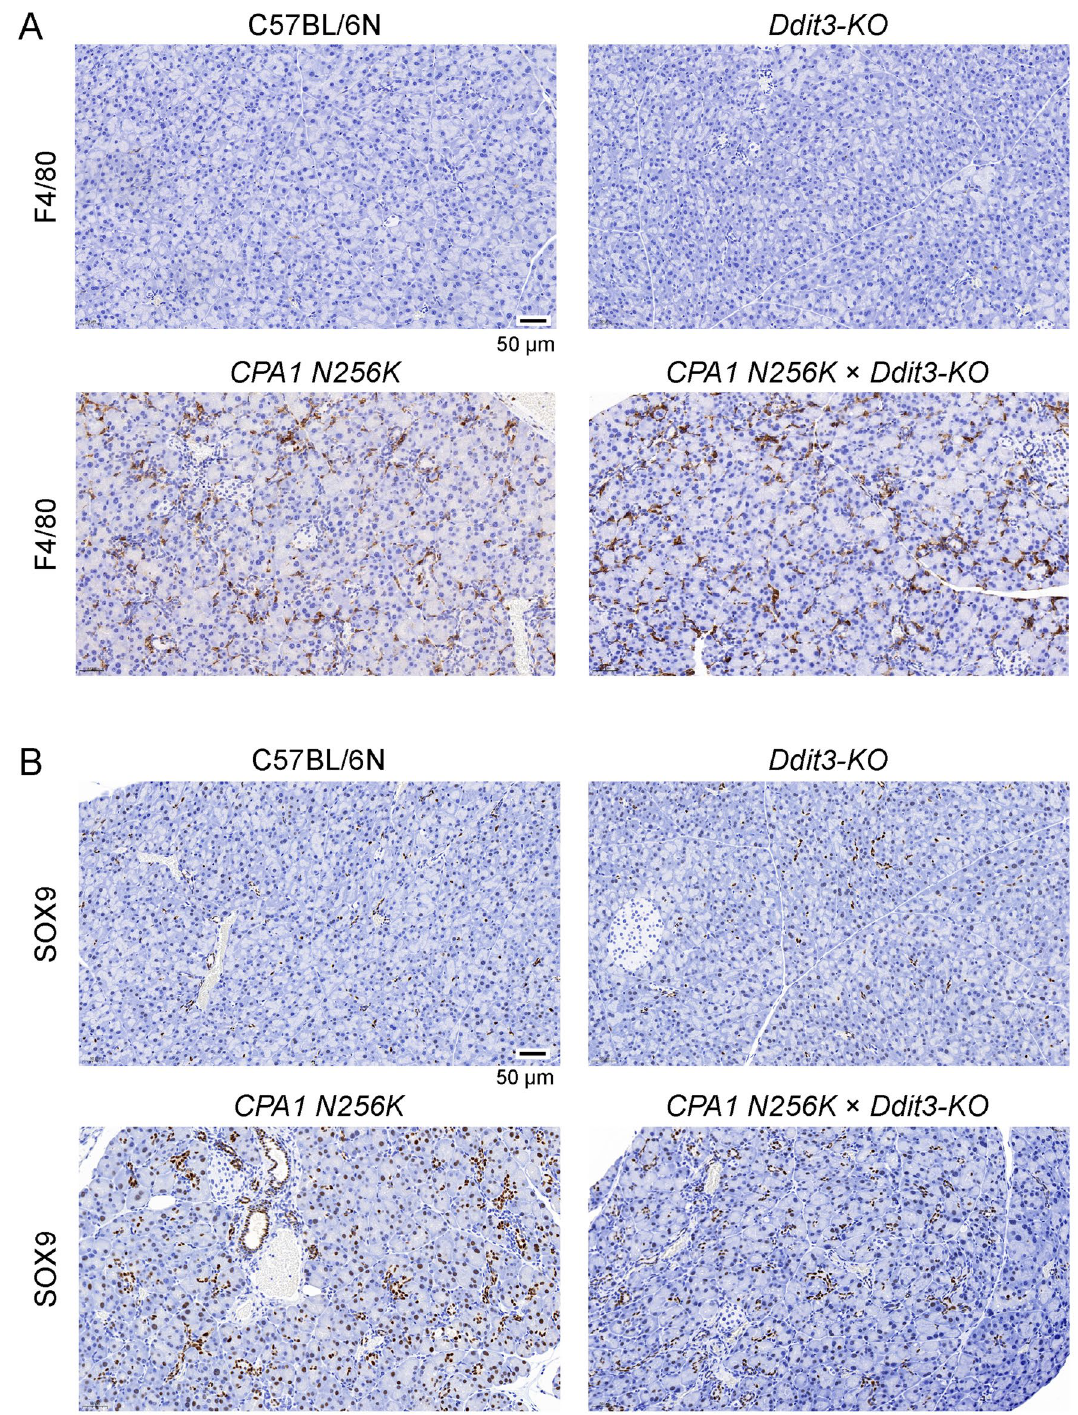
Figure 6. Macrophage infiltration and acinar-to-ductal metaplasia in the pancreas of CPA1 N256K × Ddit3-KO mice. ( A ) Immunohistochemistry staining of pancreas sections from 3-month-old C57BL/6N, Ddit3-KO , CPA1 N256K, and CPA1 N256K × Ddit3-KO mice for the F4/80 macrophage marker. Macrophages are stained brown. ( B ) Immunohistochemistry staining of pancreas sections from 3-month-old C57BL/6N, Ddit3-KO , CPA1 N256K, and CPA1 N256K × Ddit3-KO mice for the SOX9 ductal cell marker. Normal ductal cells and acinar cells that underwent ductal metaplasia are stained brown. The scale bar corresponds to 50